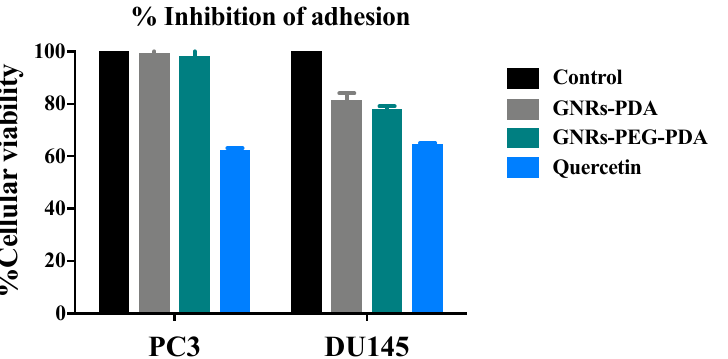
Figure 12. Percent inhibition of adhesion of GNRs-PDA and GNRs-PEG-PDA compared to untreated cells (control) and positive control (Quercetin).